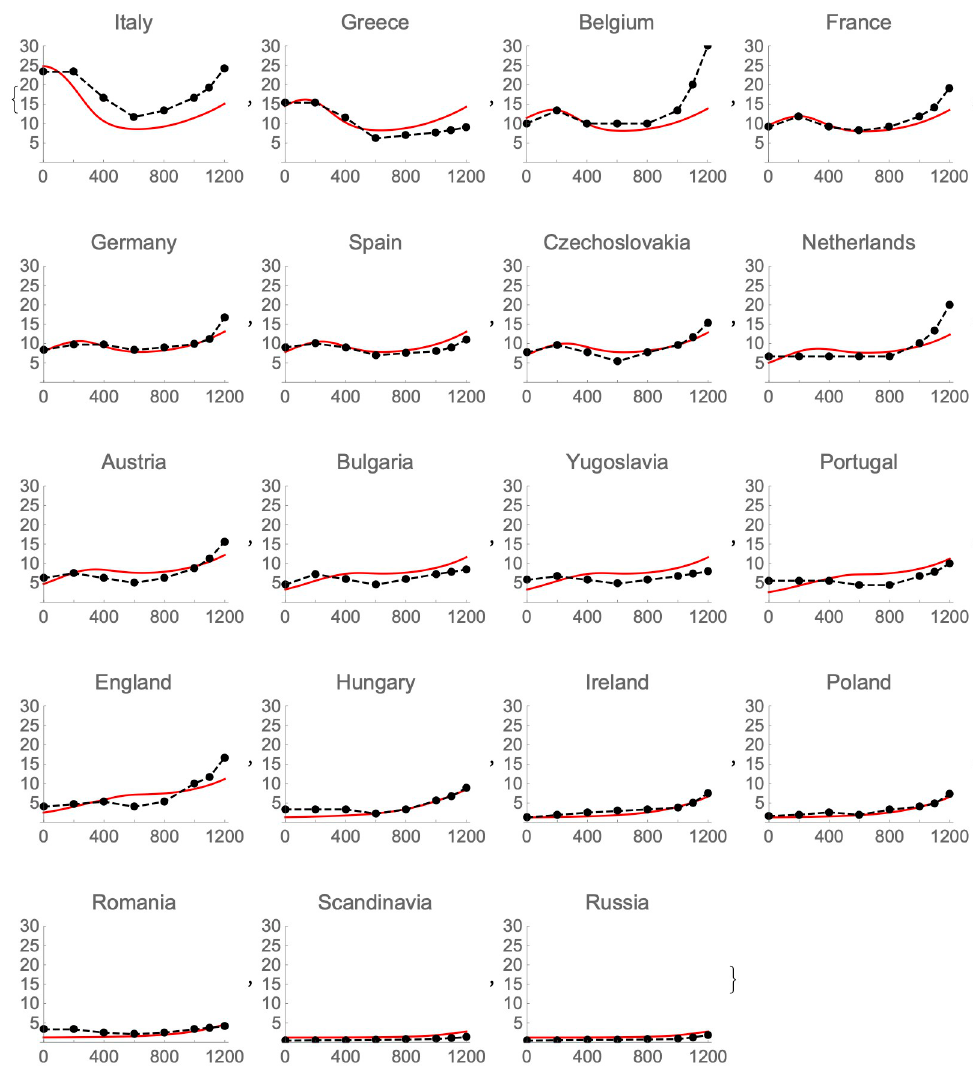
Fig 7. Barbarigenesis and the fates of nations. Population densities for 19 countries, estimated (points and dashes) and predicted by the model (solid lines). The x-axis is years CE, y-axis is population per square kilometer.